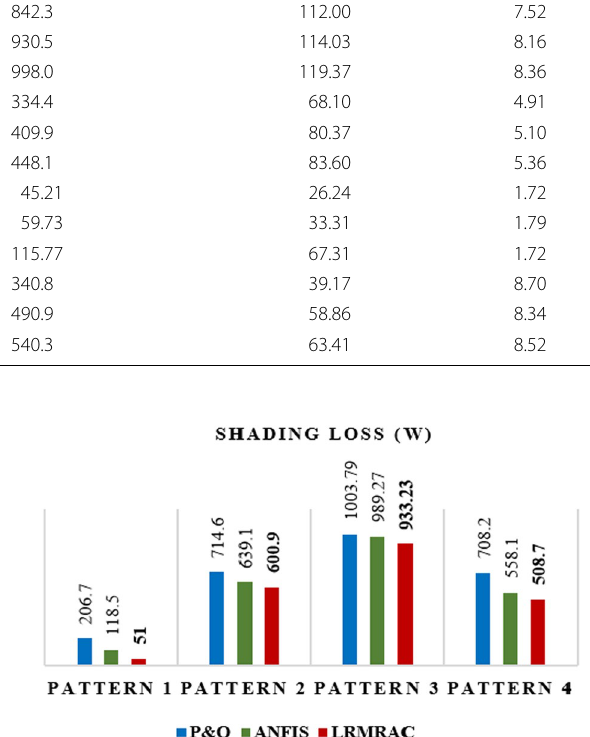
Fig. 23 Comparative analysis of shading loss